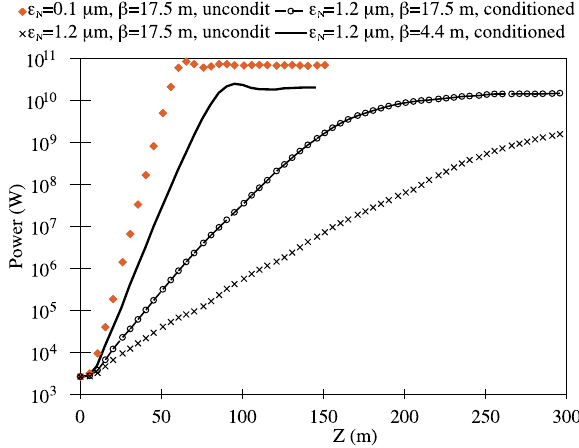
FIG. 6. (Color) Radiation power as a function of undulator length for a Greenfield FEL at 28 GeV. Different beta functions and emittances are shown, with conditioned and unconditioned